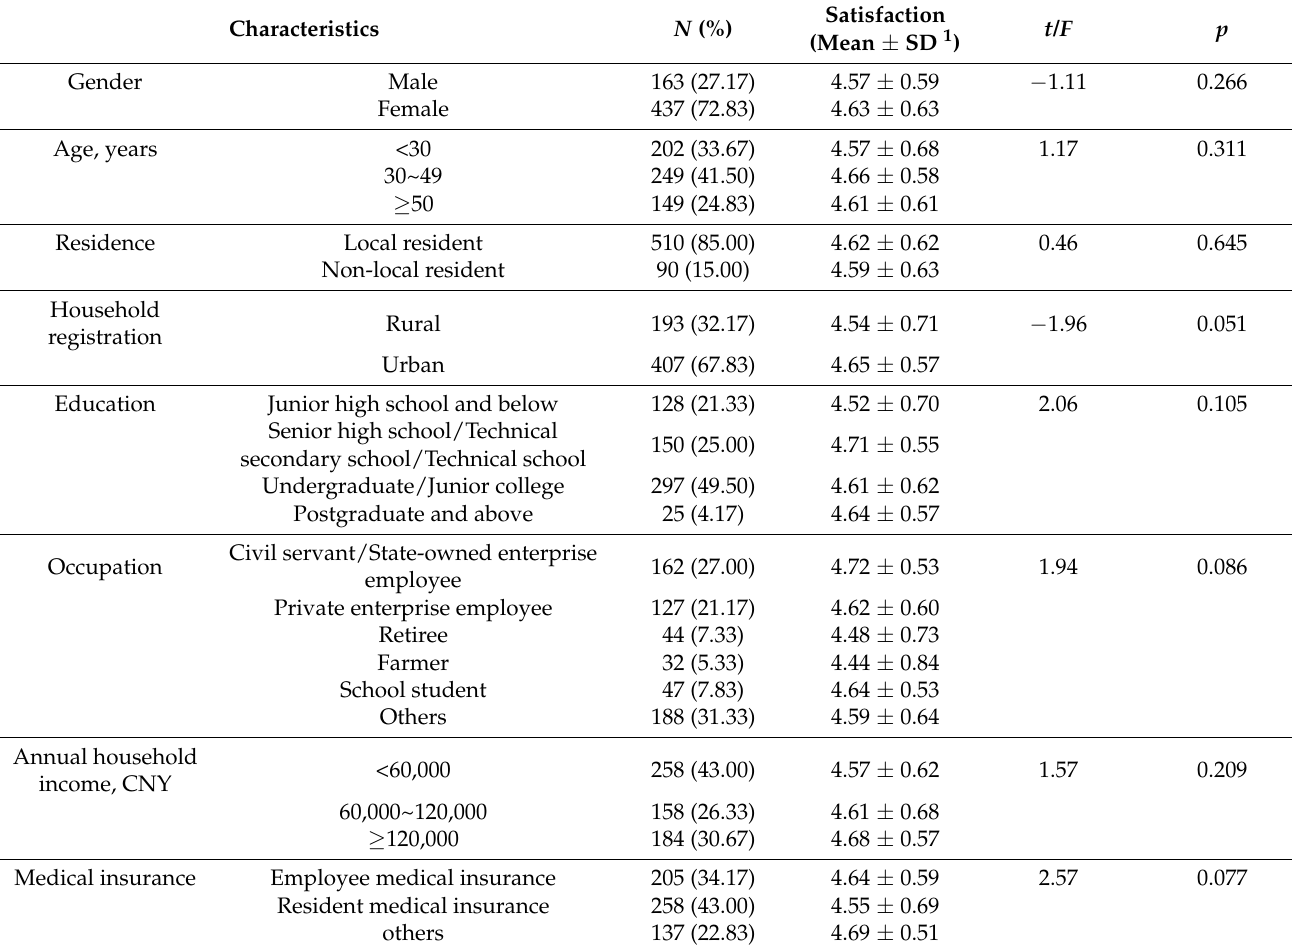
Table 1. Characteristics of the